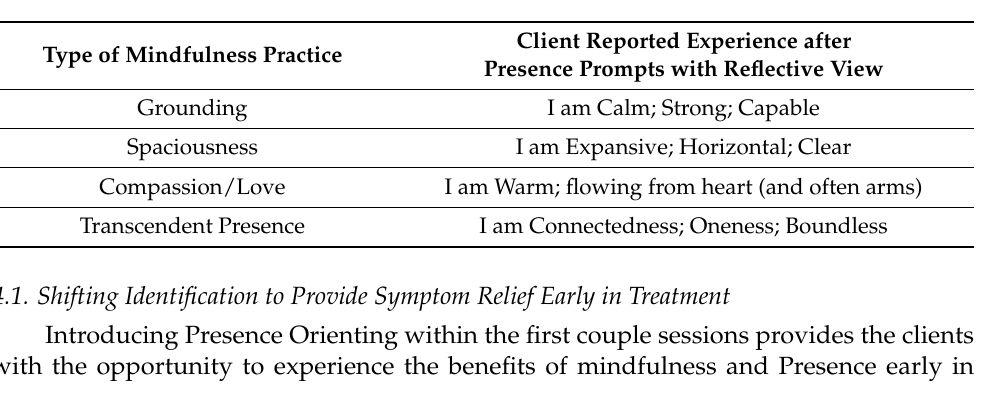
Table 1. Anecdotal Client responses to Open-Ended Presence Prompts following mindfulness